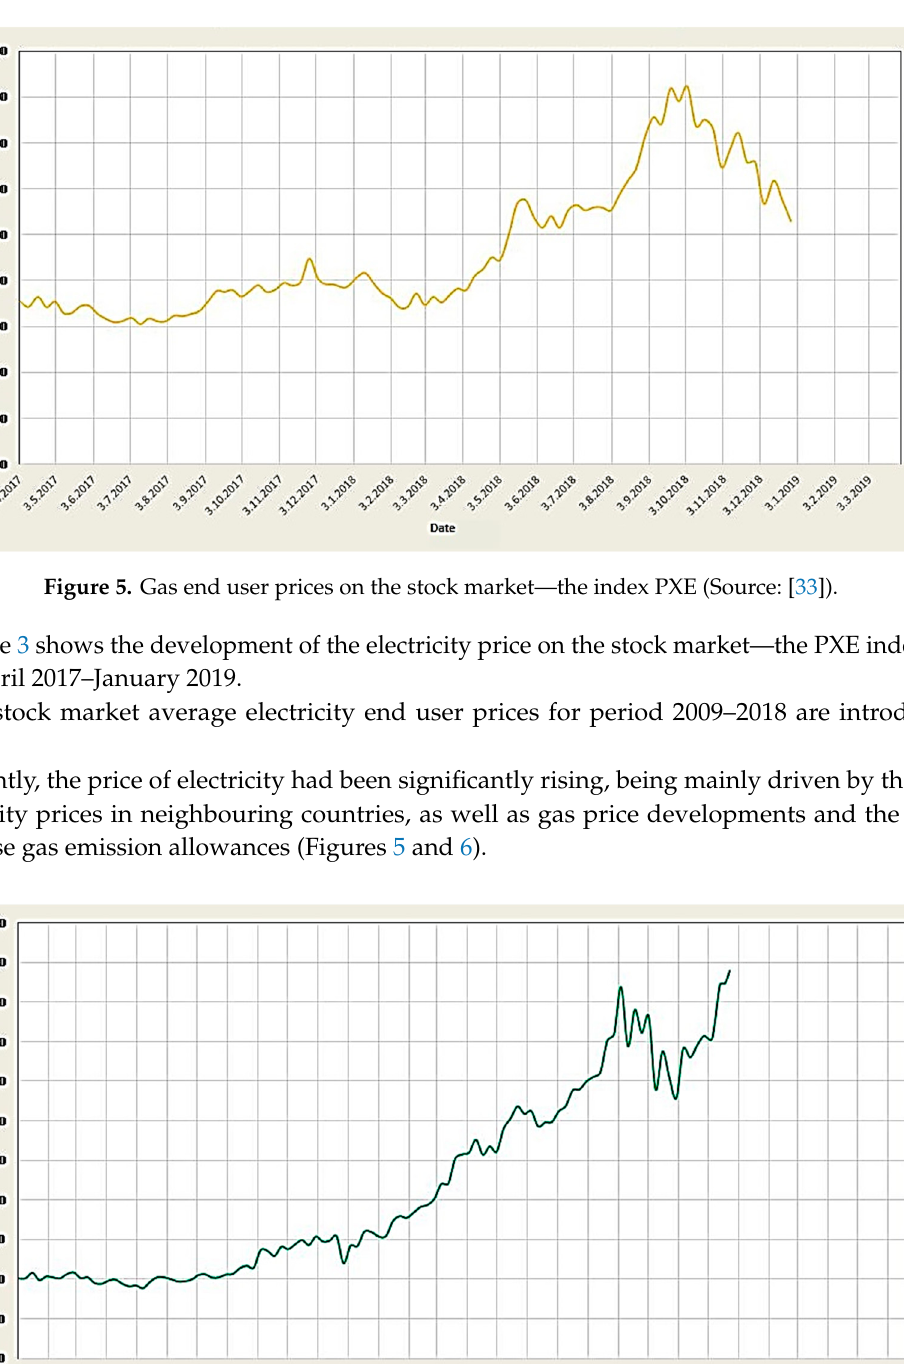
Figure 6. End user prices of emission allowances for greenhouse gases (Source: [34]).